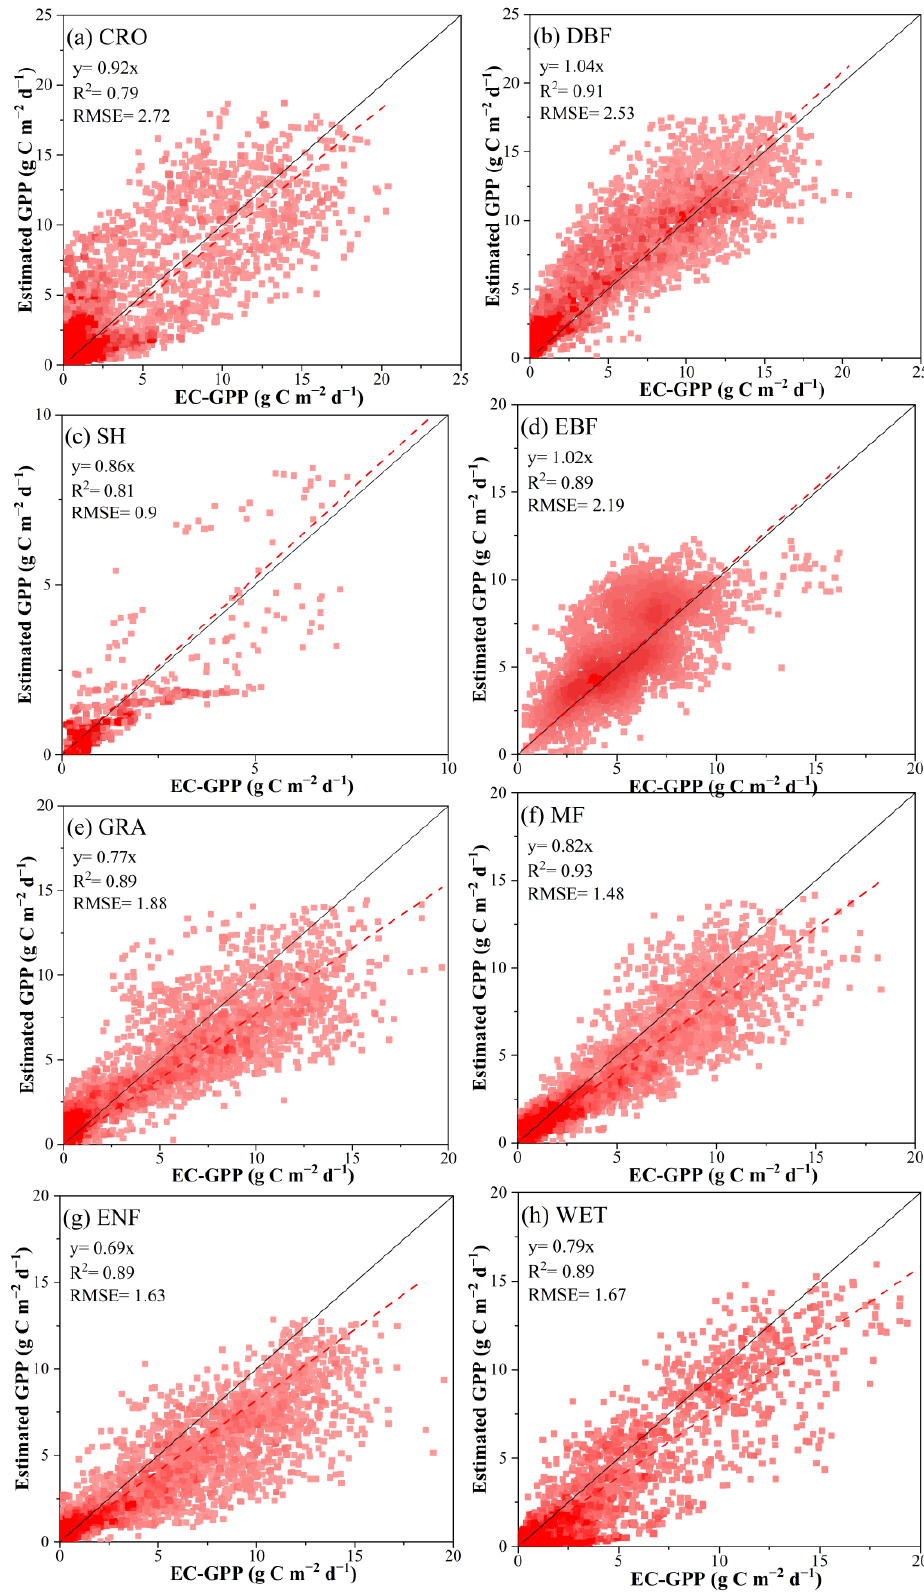
Figure 4. Model validation accuracy for nine PFTs: ( a ) CRO, ( b ) DBF, ( c ) SH, ( d ) EBF, ( e ) GRA, ( f ) MF, ( g ) ENF, and ( h ) WET.